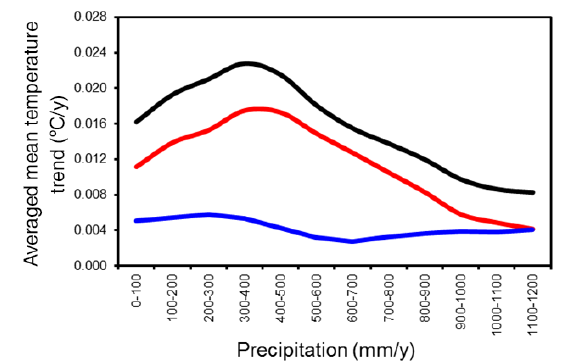
Figure 6. Regionally averaged cold season mean-temperature trend as a function of annual precipitation for raw (black), dynamically induced (blue), and radiatively forced (red) temperatures in the cold season from 1902 to 2011 over east